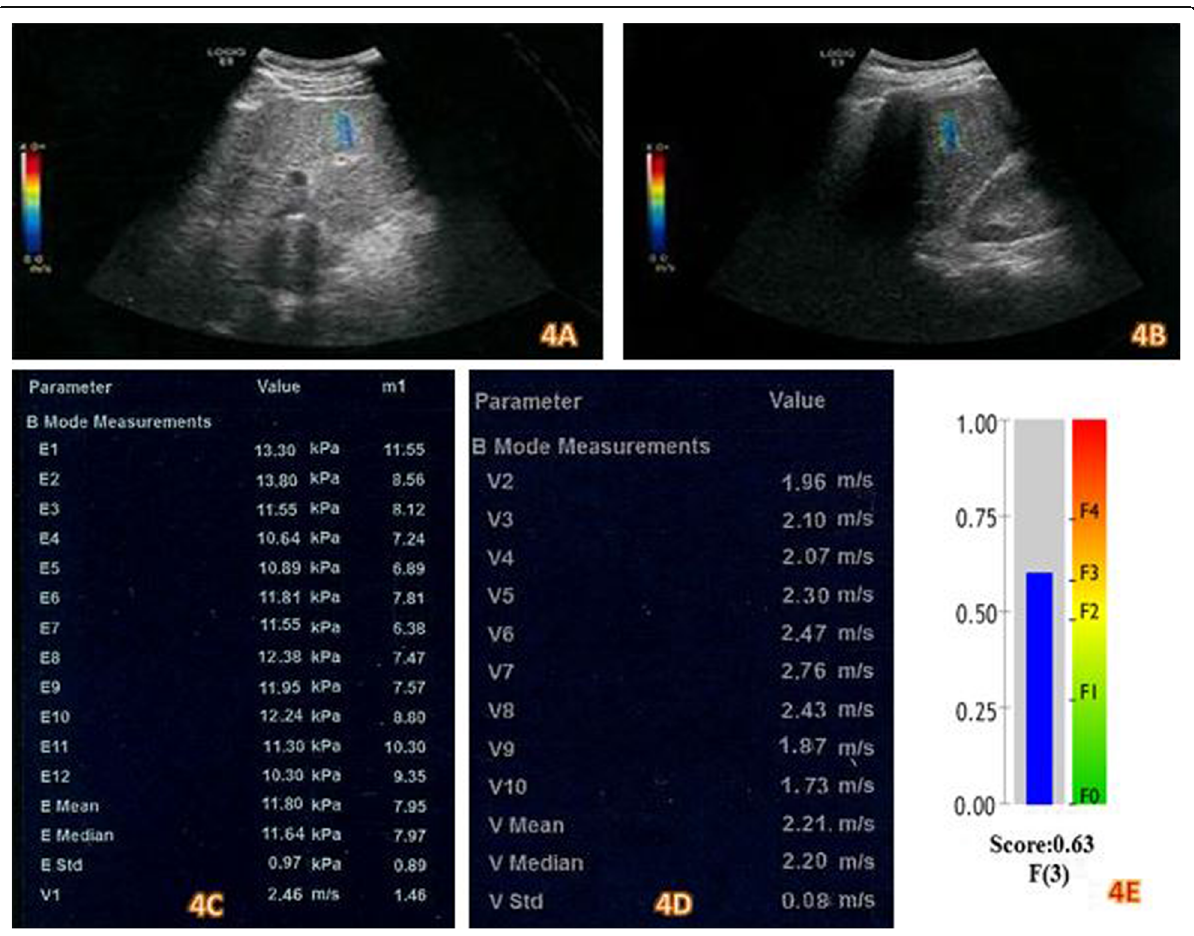
Fig. 4 F3 stage: A male patient aged 57 years old with HCV chronic hepatitis and slightly elevated AST and ALT. Conventional US reveals the following ( a and b ): Liver >>wave form surface (score 2), coarse with reticular pattern (score 3), hepatic veins with irregular wall, and normal caliber (score 2) “ cumulated score 7. ” Mild ascites, enlarged spleen size (longitudinal axis=160 mm), dilated portal vein caliber (14.6 mm), multiple GB stones. 2D shear wave elastography ( c and d ): Velocity median value = 2.20 m/s. Stiffness median value =11 kPa. Fibrotest result was 0.63 denoting F3 stage ( e